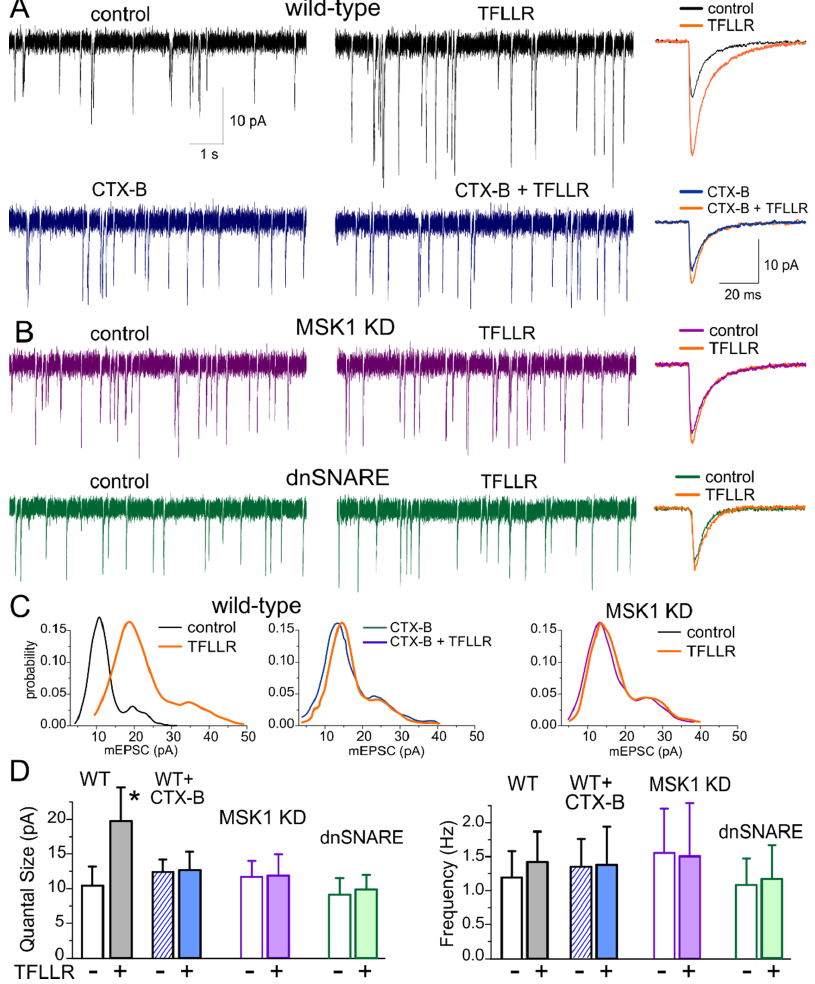
Figure 1. MSK1 and BDNF mediate astroglia-induced synaptic scaling in hippocampal